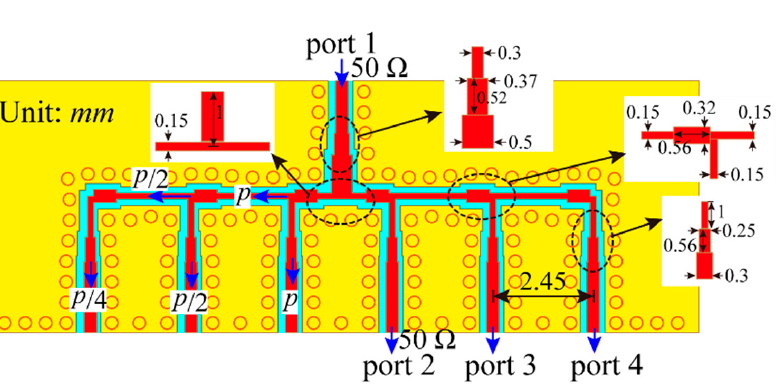
Figure 4. The geometry of the designed series feeding network. (The impedance of the input and outputs are 50 Ω . The p denotes power.).